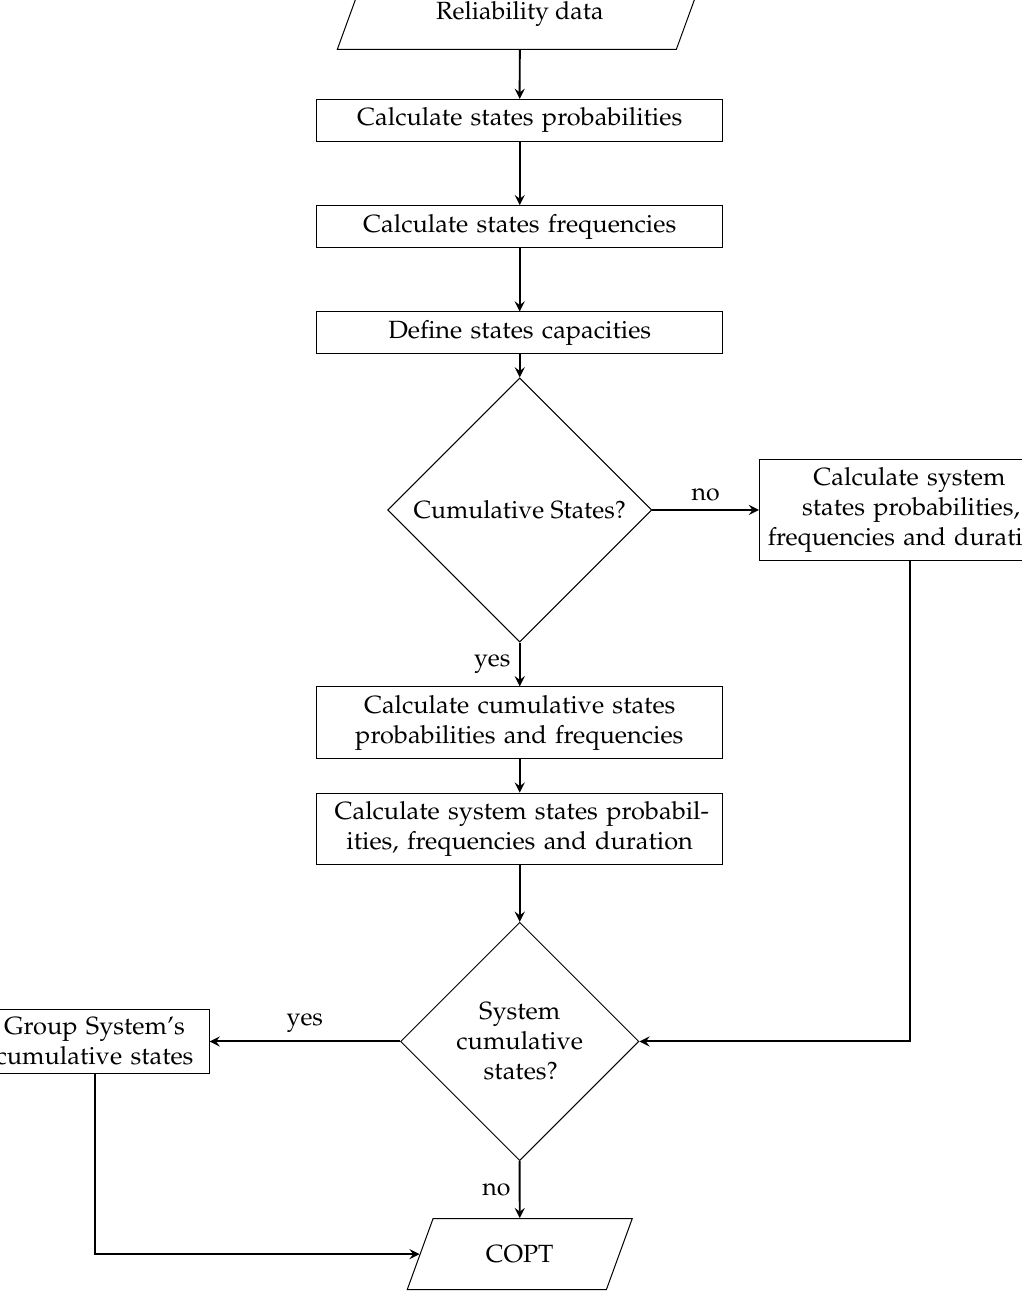
Figure 5. Capacity outage probability table calculation method flow